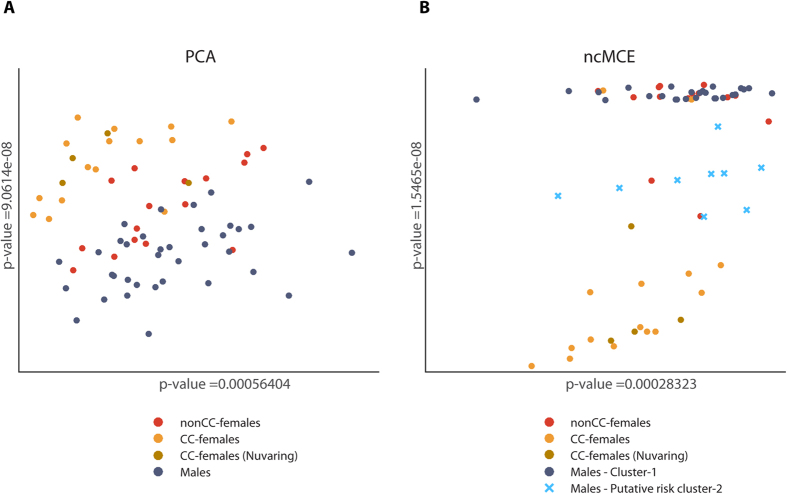
Unsupervised multivariate analyses by PCA and ncMCE reveal compositionally distinct lipidome clusters.Both PCA (A) and ncMCE (B) reveal a cluster of lipidomes of females taking hormonal contraceptives (CC-females, n = 19) (p < 0.001). CC-females (Nuvaring) indicate individuals using vaginal rings while other CC-females were taking pills. Among male lipidomes, ncMCE (B) distinguishes Cluster I (n = 27) and Cluster II (n = 9).